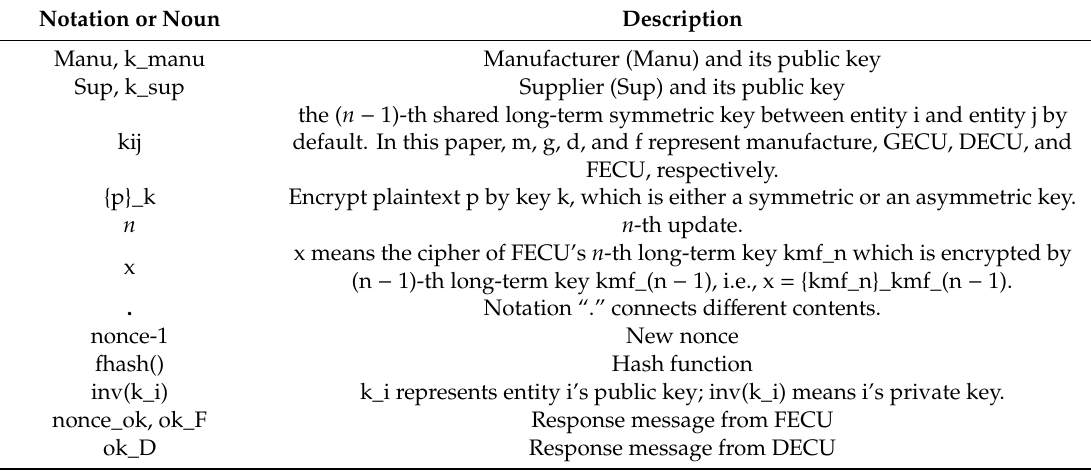
Figure 5. Simulation of the proposed OTA-based key update protocol. Table 4. Notation or functions used for proposed OTA-based key update mechanism.